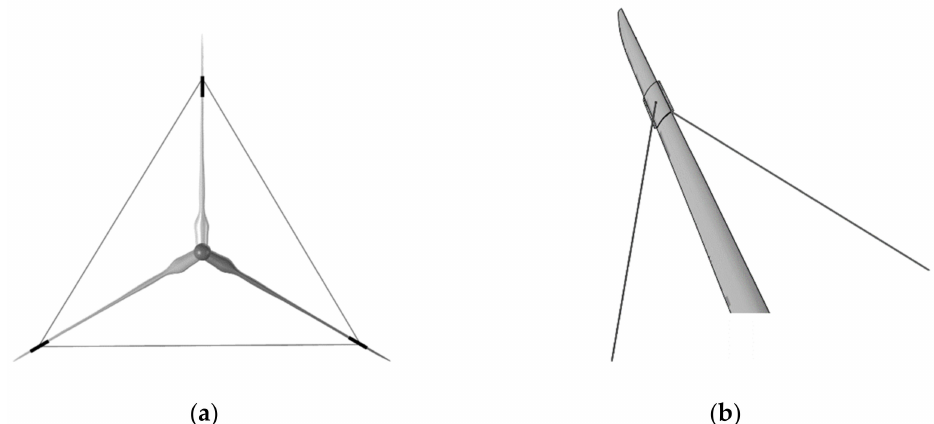
Figure 4. Three-dimensional structural model of blades with reinforcing cable component: ( a ) Wind turbine with reinforcing cable component; ( b ) Mechanical connector for RCC.